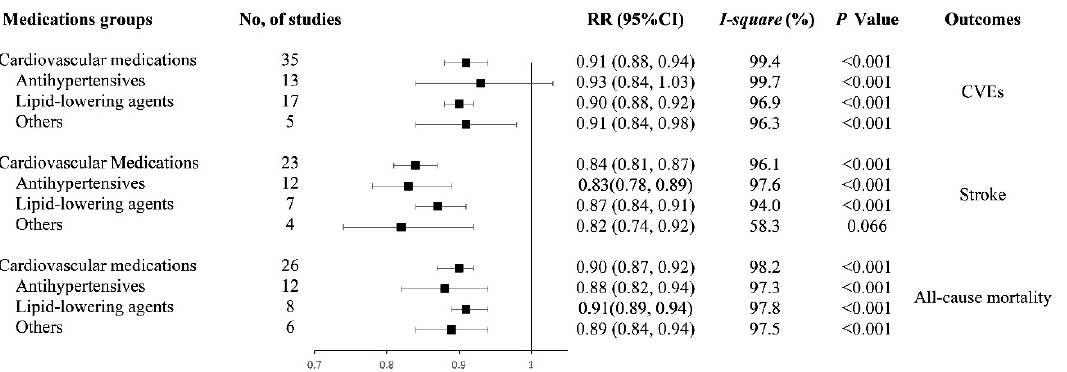
Figure 3. ( a ) Pooled dose-response analysis of cardiovascular medication adherence and cardiovascular events risk (solid line). ( b ) Pooled dose-response analysis of cardiovascular medication adherence and stroke risk (solid line). ( c ) Pooled dose-response analysis of cardiovascular medication adherence and all-cause mortality risk (solid line). Dashed lines rep- resent the 95% CI.